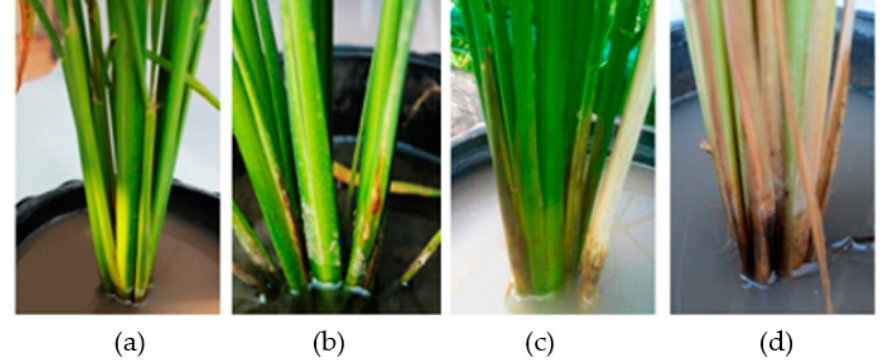
Figure 1. Rice sheath blight disease lesions 15 days after R. solani DOAC 1406 inoculation. ( a ) Negative control: rice plant sprayed with distilled water, ( b ) rice plant inoculated with R. solani DOAC 1406 and sprayed with 3% validamycin, ( c ) rice plant inoculated with R. solani DOAC 1406 and sprayed with cell suspension of T. indica DMKU-RP31 and ( d ) positive control: rice plant inoculated with R. solani DOAC 1406 without any